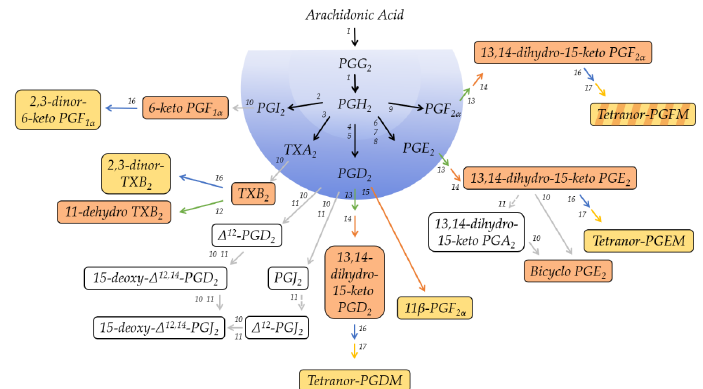
Figure 1. Schematic overview of the prostanoid pathway with the major metabolites that can be detected in human plasma or urine, respectively. The individual metabolites are described in detail in the text. Metabolites on a red background are regarded as major plasma metabolites; metabolites on a yellow background are major urinary metabolites. Red arrows indicate reduction, green, blue, or yellow arrows oxidation, and grey arrows non ‐ enzymatic reactions. 1, Cyclooxygenase ‐ 1/2 (COX, EC 1.14.99.1); 2, Prostacyclin Synthase (PTGIS, EC 5.3.99.4); 3, Thromboxane A Synthase (TBXAS1, EC 5.3.99.5); 4, Hematopoietic Prostaglandin D Synthase (HPGDS, EC 2.5.1.18); 5, Lipocalin ‐ Type Prostaglandin D Synthase (L ‐ PGDS, EC 5.3.99.2); 6, Microsomal Prostaglandin E Synthase ‐ 1 (MPGES1, EC 5.3.99.3); 7, Microsomal Prostaglandin E